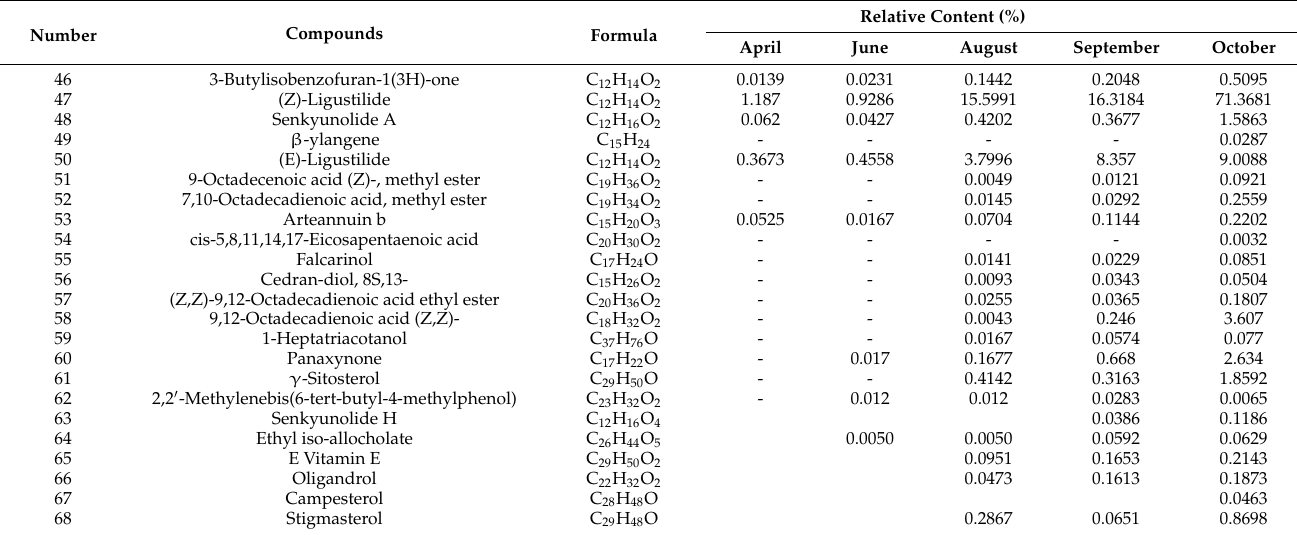
Figure 6. Total ion chromatogram from the tail of A. sinensis in different periods. Note: The com- pounds represented by peaks 1~9 are the same as the compounds in Figure 2. Table 3. Analysis of chemical composition in the tail of A. sinensis in different periods. Num- ber Compounds